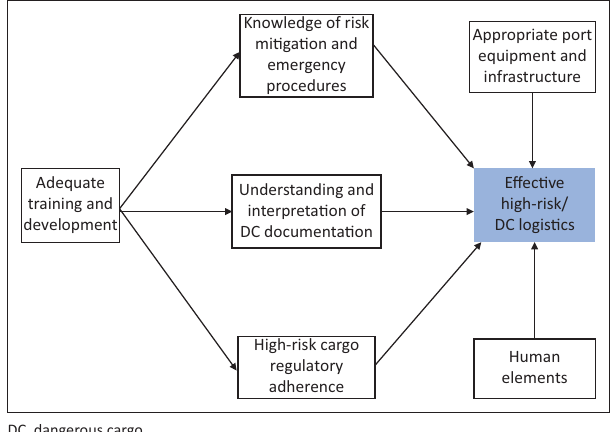
FIGURE 4: Determinants of effective high-risk cargo logistics.